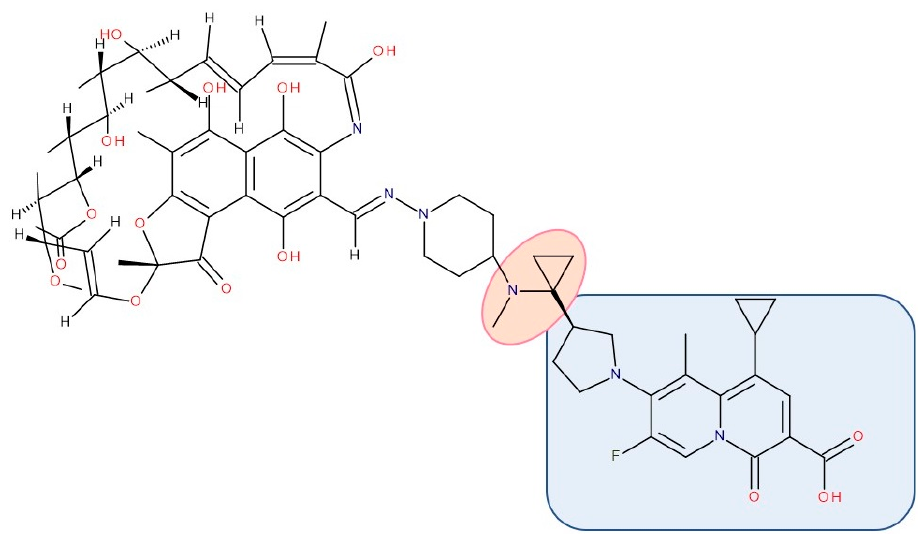
Figure 10. Antibiotic–antibiotic hybrid containing an FQN: rifampicin derivative–linker–ciprofloxacin derivative; the linker is highlighted with the orange circle while the QN/FQN unit is highlighted by the blue rectangle [268].